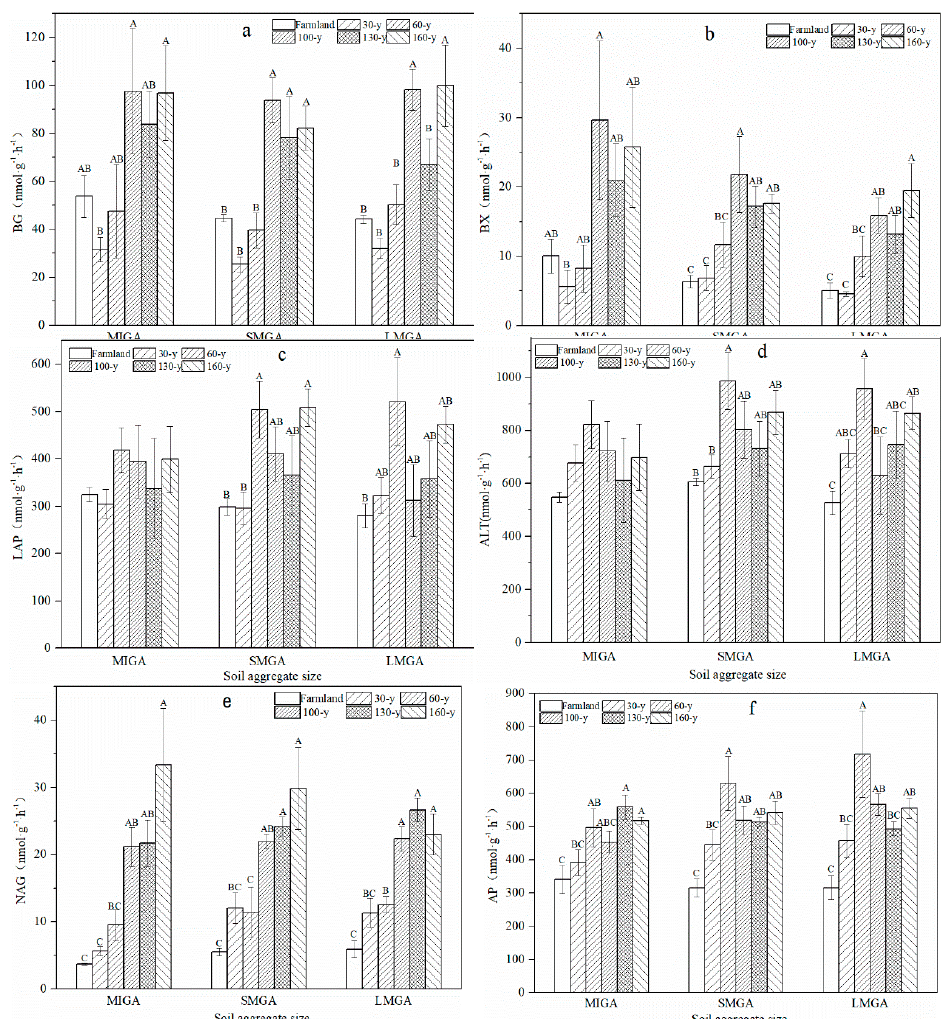
Figure 5. Changes in BG ( a ), BX ( b ), NAG ( c ), LAP ( d ), ALT ( e ), and AP ( f ) in di ff erent sizes of soil aggregates with the vegetation succession. Error bars denote Standard error. Letters above the bars are for comparison in the size of the same aggregates at the di ff erent restoration stages, bars with the same letter are not significantly di ff erent at p = 0.05. BG: β -1, 4-glucosidase, BX: β -1,4-xylosidase, NAG: β -N-acetyl glucosaminidase, LAP: leucine aminopeptidase, ALT: alanine- α -aminopeptidase, AP: alkali phosphatase.